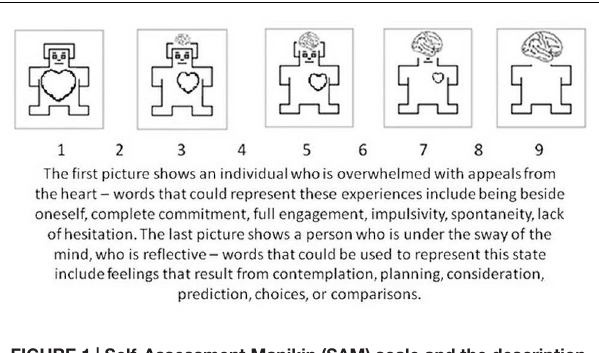
FIGURE 1 | Self-Assessment Manikin (SAM) scale and the description developed for use in measuring the origin dimension in the Affective Norms for Polish Words study (Imbir,